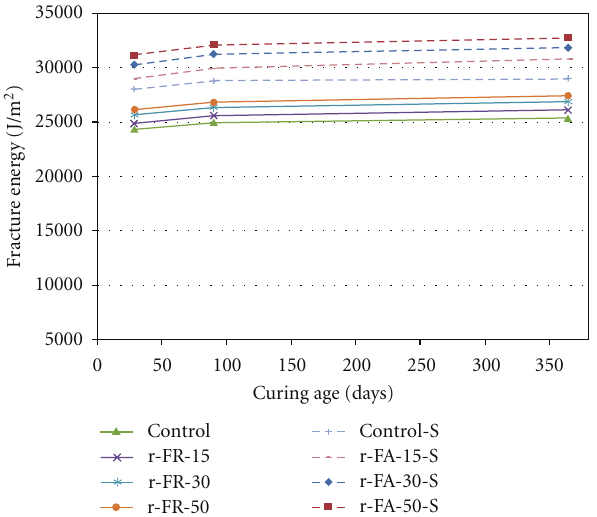
Figure 9: E ff ect of r-FA on fracture energy of UHPFRC with and without steam curing.